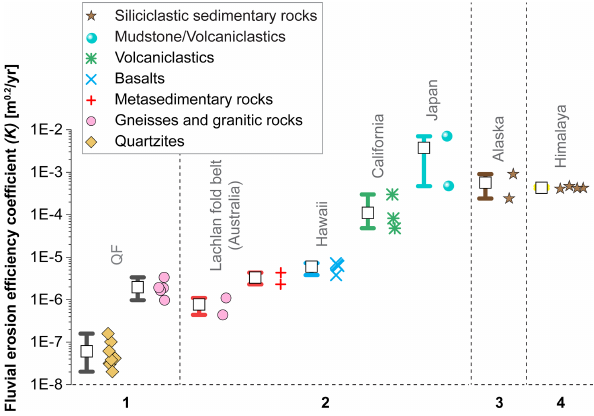
Figure 7. Comparison of our results for the fluvial erosion effi- ciency coefficient ( K ) with previously published estimates of K . Note that we display whiskers (representing the interval between the 10th and 90th percentiles of the data) and mean values (white squares) on the left and raw data (diamonds) on the right. Estimates of K were derived assuming the slope exponent n = 1. Numbers on the x axis represent different data sources: (1) this study; (2) Stock and Montgomery (1999); (3) Whipple et al. (2000b); (4) Kirby and Whipple (2001). Lithology was compiled as described by the re- spective authors of the above